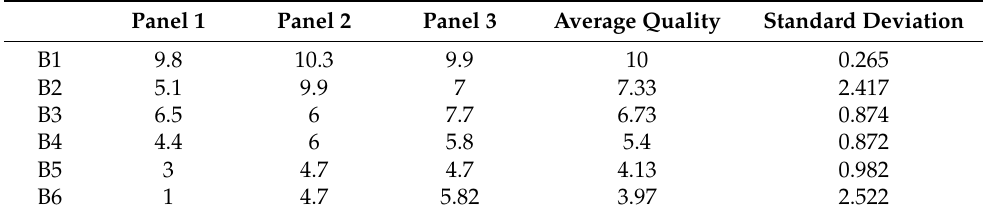
VOO, virgin olive oil; B1 to B6, anonymized codes for olive oil brands. Table 2. Average quality of the VOOs calculated from the sensory analysis. Panel